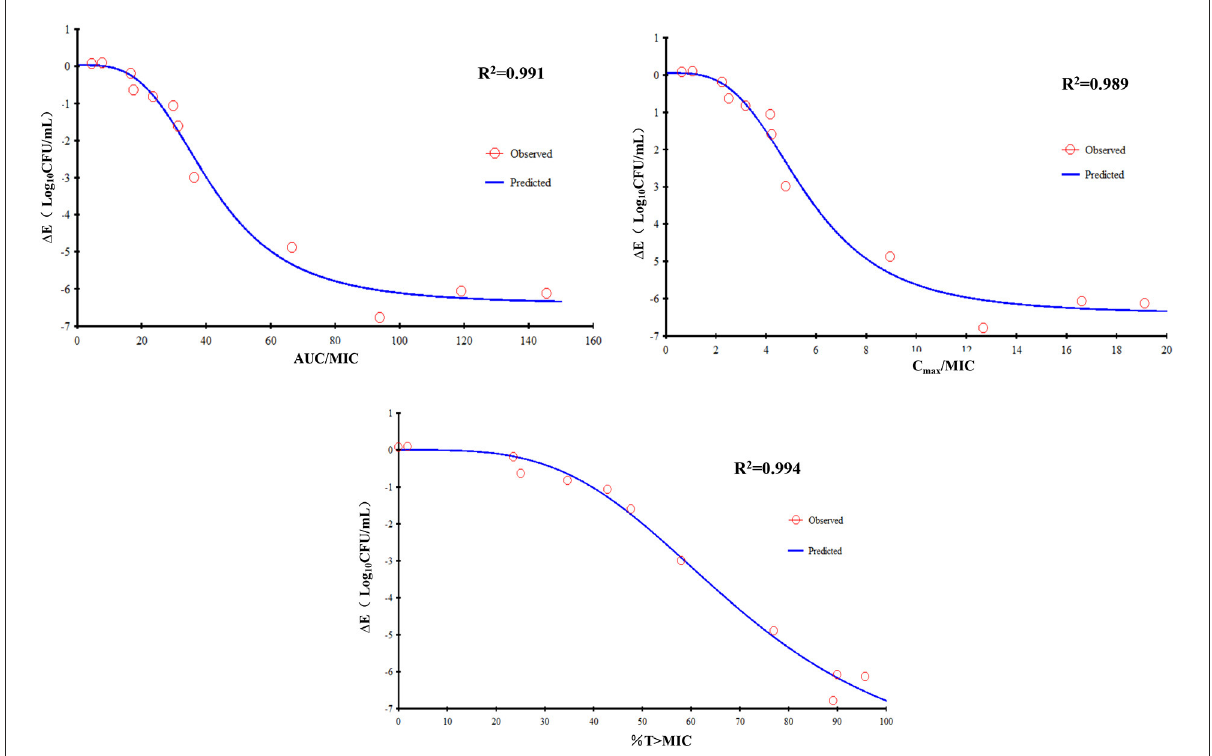
FIGURE5 E max relationships for the three PK/PD parameters of florfenicol used alone vs. the antibacterial effect.